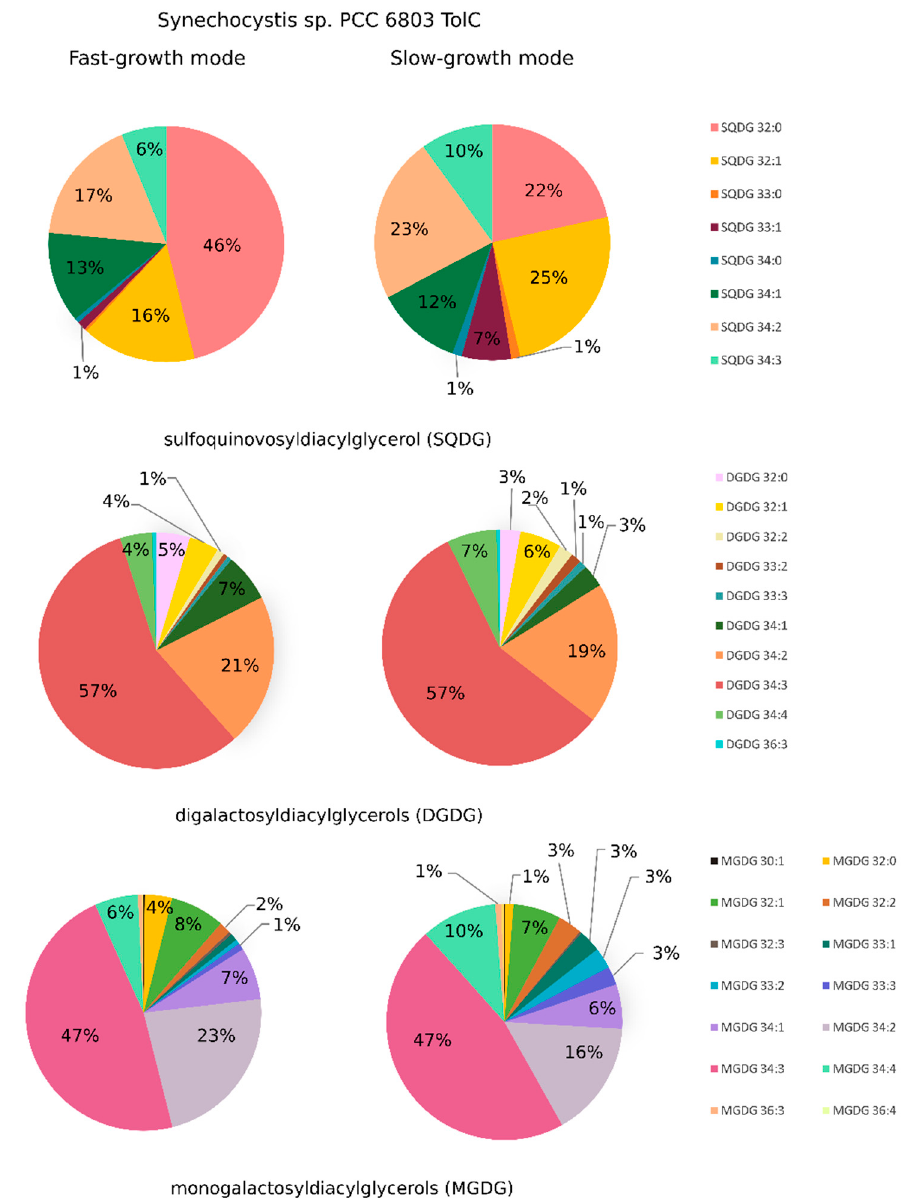
Figure 7. The lipidome of Synechocystis sp. PCC 6803 tolC -mutant strain as determined in this work. Relative amount of lipid species (presented as average percentage) within the classes MGDG (monogalactosyldiacylglycerols), DGDG (digalactosyldiacylglycerols), and SQDG (sulfoquinovosyldiacylglycerol), detected in Synechocystis sp. PCC 6803 tolC -mutant cells cultivated photoautotrophically either in fast-growth mode (FGM) or in slow-growth mode (SGM). For each lipid class, percentages were calculated based on the average peak area of each lipid species, and on the average peak area of the total lipid species within that lipid class.